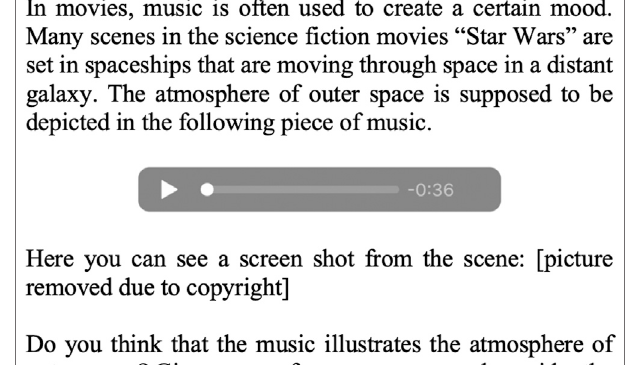
FIGURE 1 | Test item “ Star Wars ” (English translation). The participants listen to an excerpt from the fi lm score ( “ Arrival at Naboo ” from Episode I). A screenshotfromthescene wasshownintheitembut hadtoberemovedhere due tocopyright issues. The screenshot shows theviewofaplanet from a space shuttle